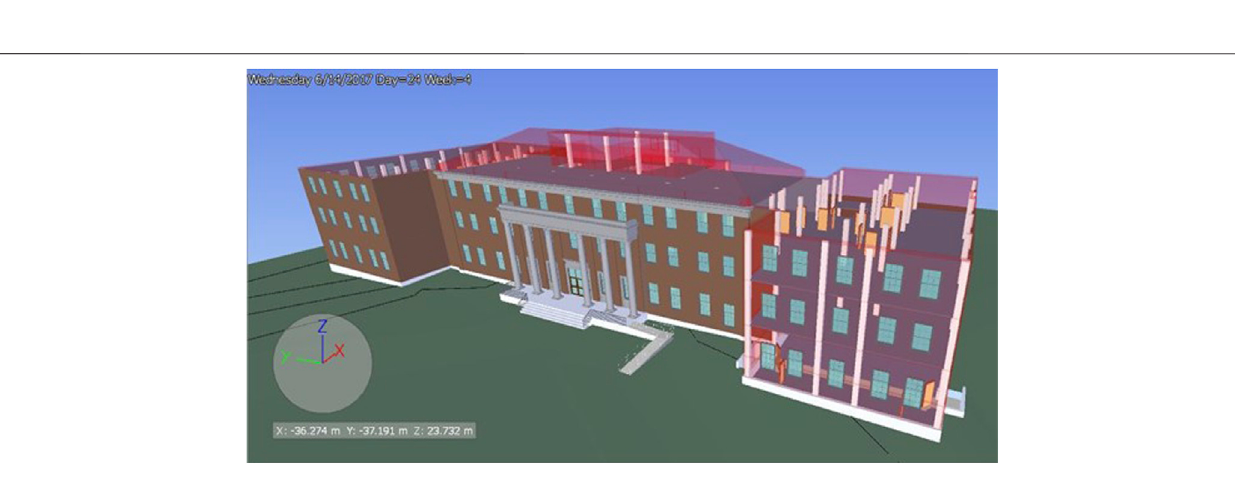
FIGURE 6 | A snapshot of Day 24-Week 4